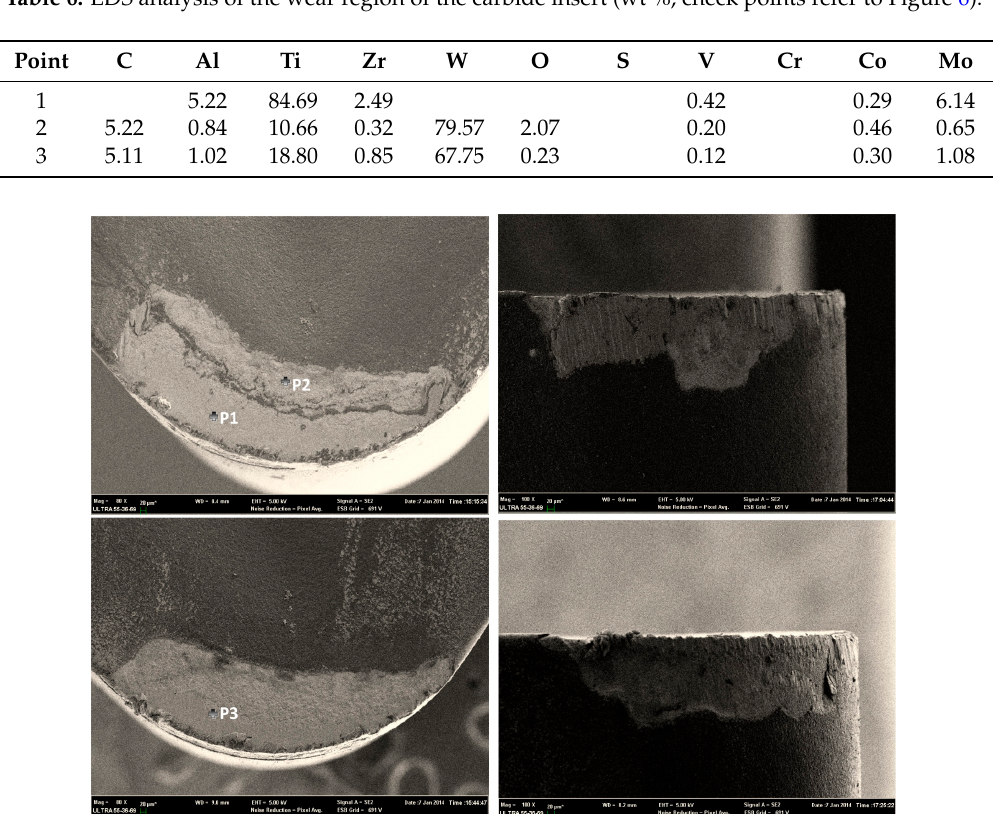
Table 6. EDS analysis of the wear region of the carbide insert (wt %, check points refer to Figure 6).